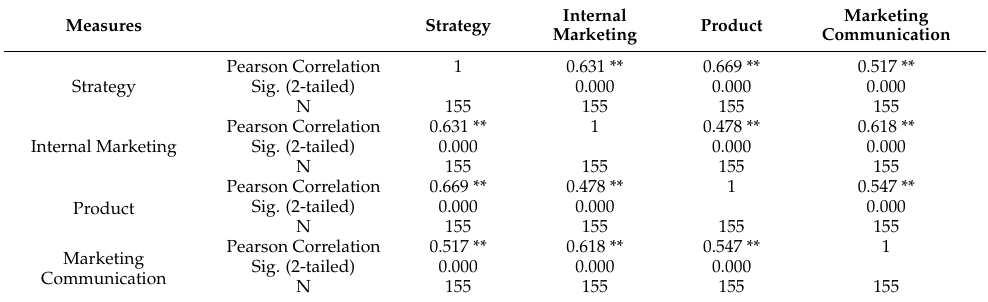
Table 7. Correlation